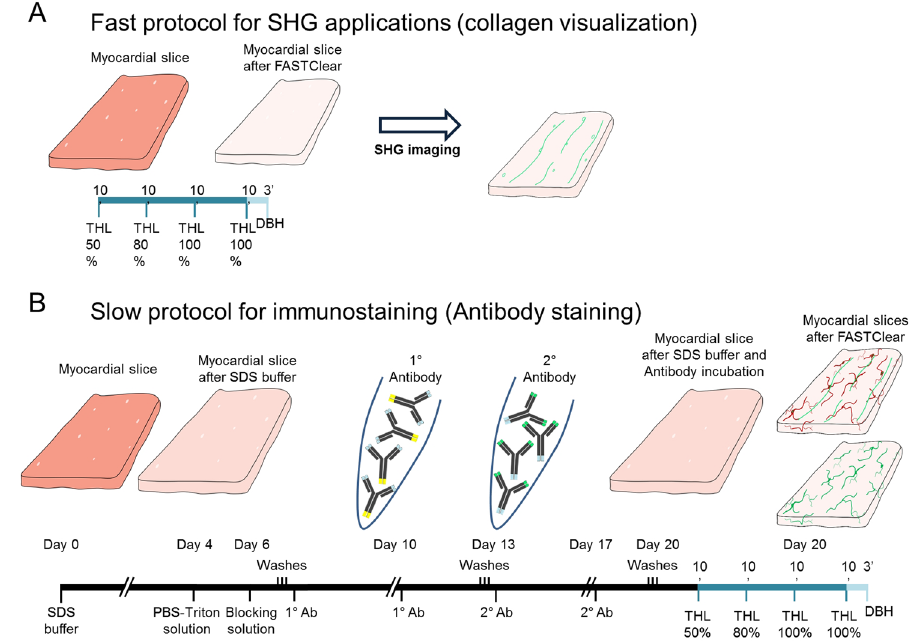
Figure 1. ( A ) Schematic representation of FASTClear protocol on freshly prepared or fixed myocardial slices and ( B ) combination of FASTClear protocol with immunostaining.